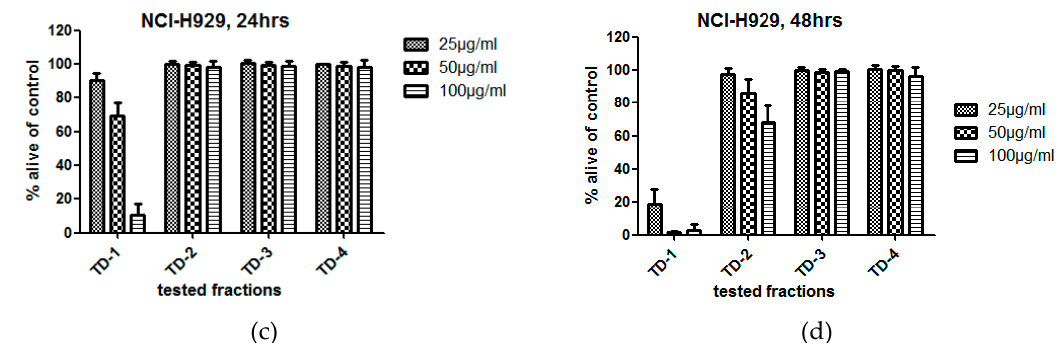
Figure 2. Viability of multiple myeloma (MM) cell lines NCI-H929, U266, and MM1S ( a ) 48 h after treatment with an acetone 70% extract of T. diffusa and after treatment with bortezomib ( b ). Viability of NCI-H929 cells 24 and 48 h after treatment with ethyl acetate (TD-1), n -butanol (TD-2), acidified n -butanol (TD-3) fractions and the remaining water layer (TD-4) derived from an acetone (70%) extract of T. diffusa ( c and d ). Three concentration levels (25, 50, 100 µg/mL) are shown.